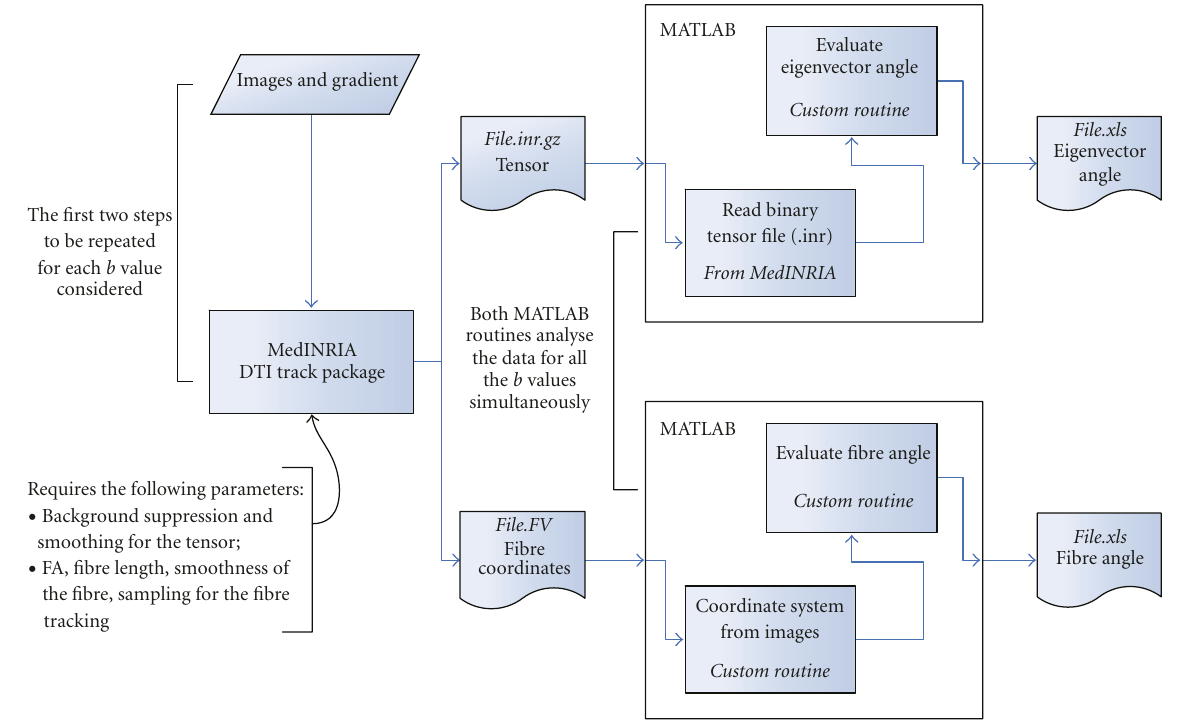
Figure 1: Flow chart indicating the various stages in the image postprocessing